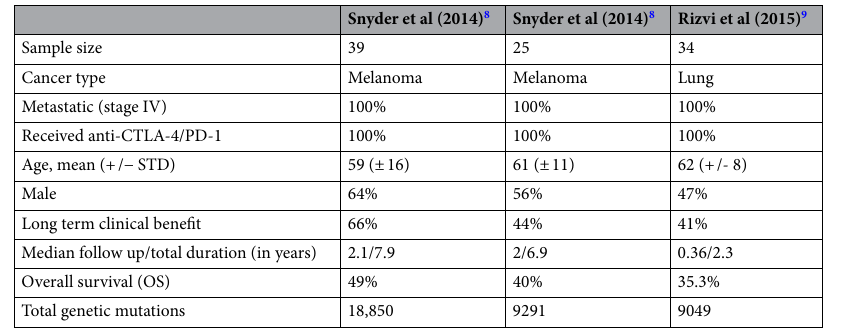
Table 1. Patient characteristics across study data